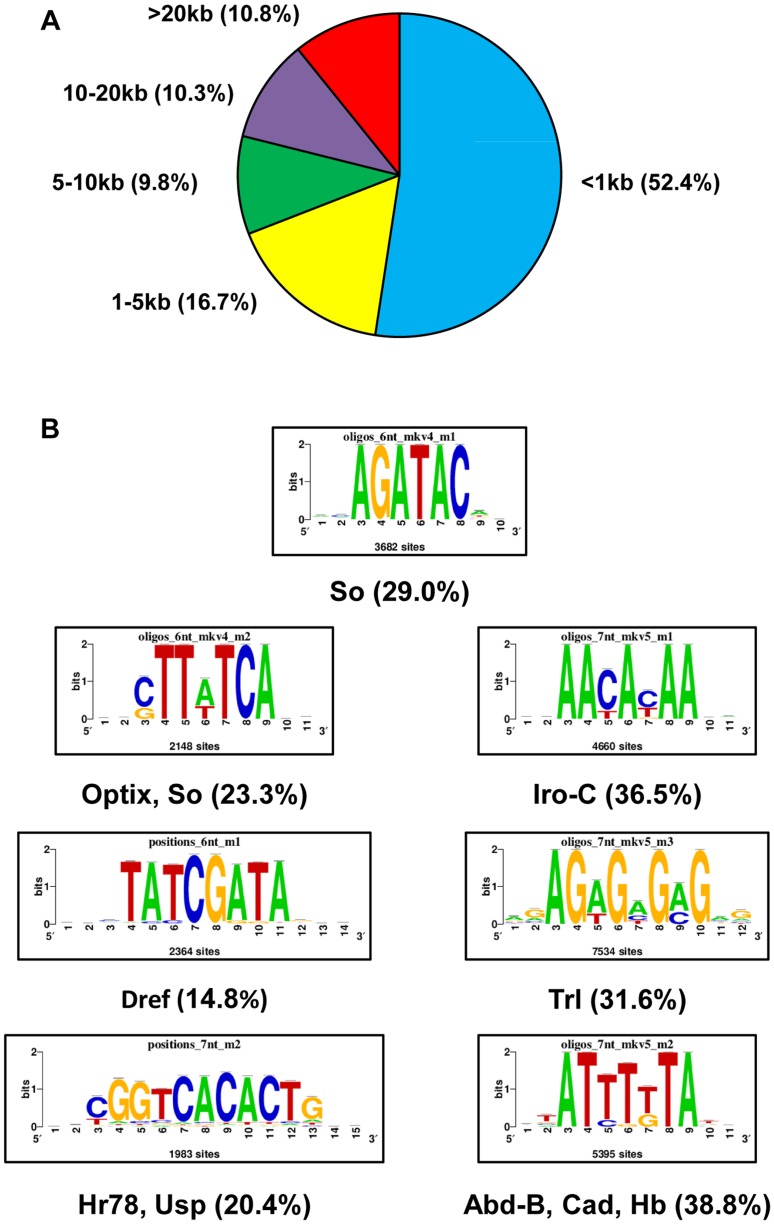
Peak distribution and motif enrichment of the So ChIP-seq data set.(A) Genome distribution of So-enriched regions (peaks) with respect to annotated transcription start sites (TSS). 52.4% of So peaks are <1 kb from the nearest TSS, and 78.9% of peaks are no more than 10 kb from the nearest TSS. (B) Transcription factor binding motifs enriched in the So ChIP-seq peak set. The name of the TF and the percentage of peaks that have at least one occurrence of the TF motif are listed under each motif. Abd-B, Abdominal-B; Cad, Caudal; Dref, DNA Replication Element factor; Hb, Hunchback; Hr78, Hormone receptor 78; Iro-C, Iroquois Complex; Trl, Trithorax-like; Usp, Ultraspiracle.